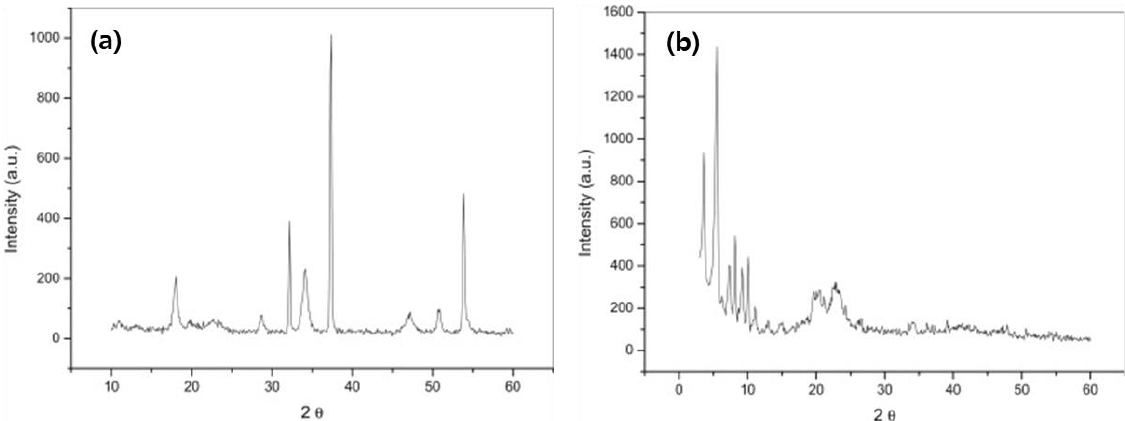
Figure 4. XRD of clamshell ( a ) calcined at 1173 K for 3.5 h and ( b ) after use. Reprinted with permission from Ref. [58]. 2022, Elsevier.